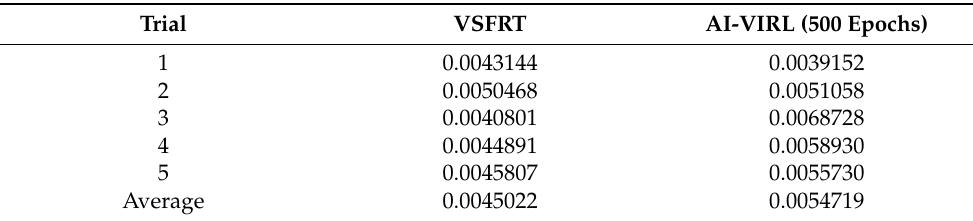
Table 6. VSFRT and AI-VIRL tracking performance when learning uses closed-loop IO data.